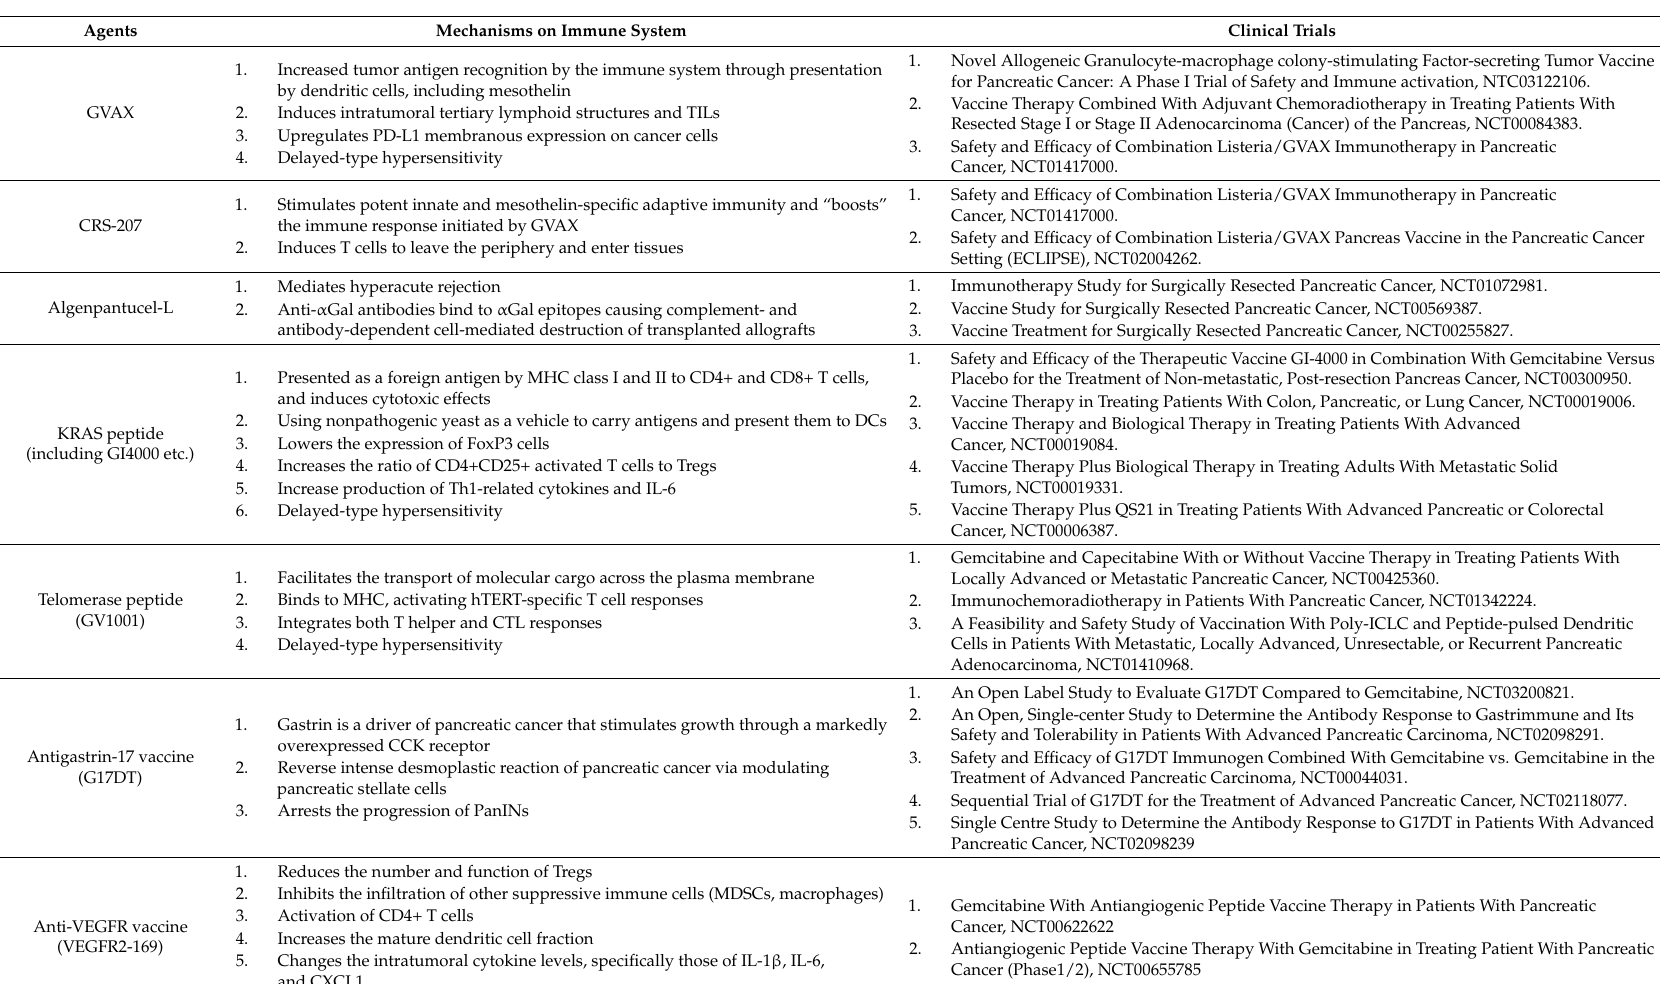
Table 2. Summary of mechanisms and trials on vaccination treatments that modulate the tumor